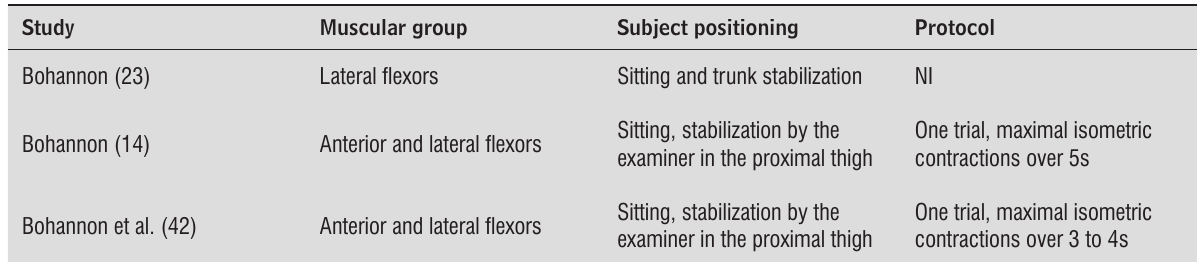
Table 1 - Data extraction of the studies which assessed the strength of the trunk muscles in subjects with stroke